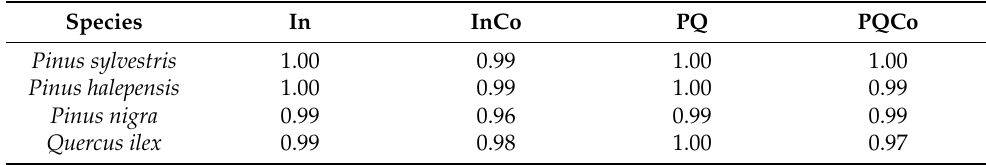
Table A3. Determination coefficient r 2 calculated over expected BA vs. observed BA by species, aggregation level (individual (In) and plot-quantile classes (PQ)), and Equations (1) and (2) (Co for